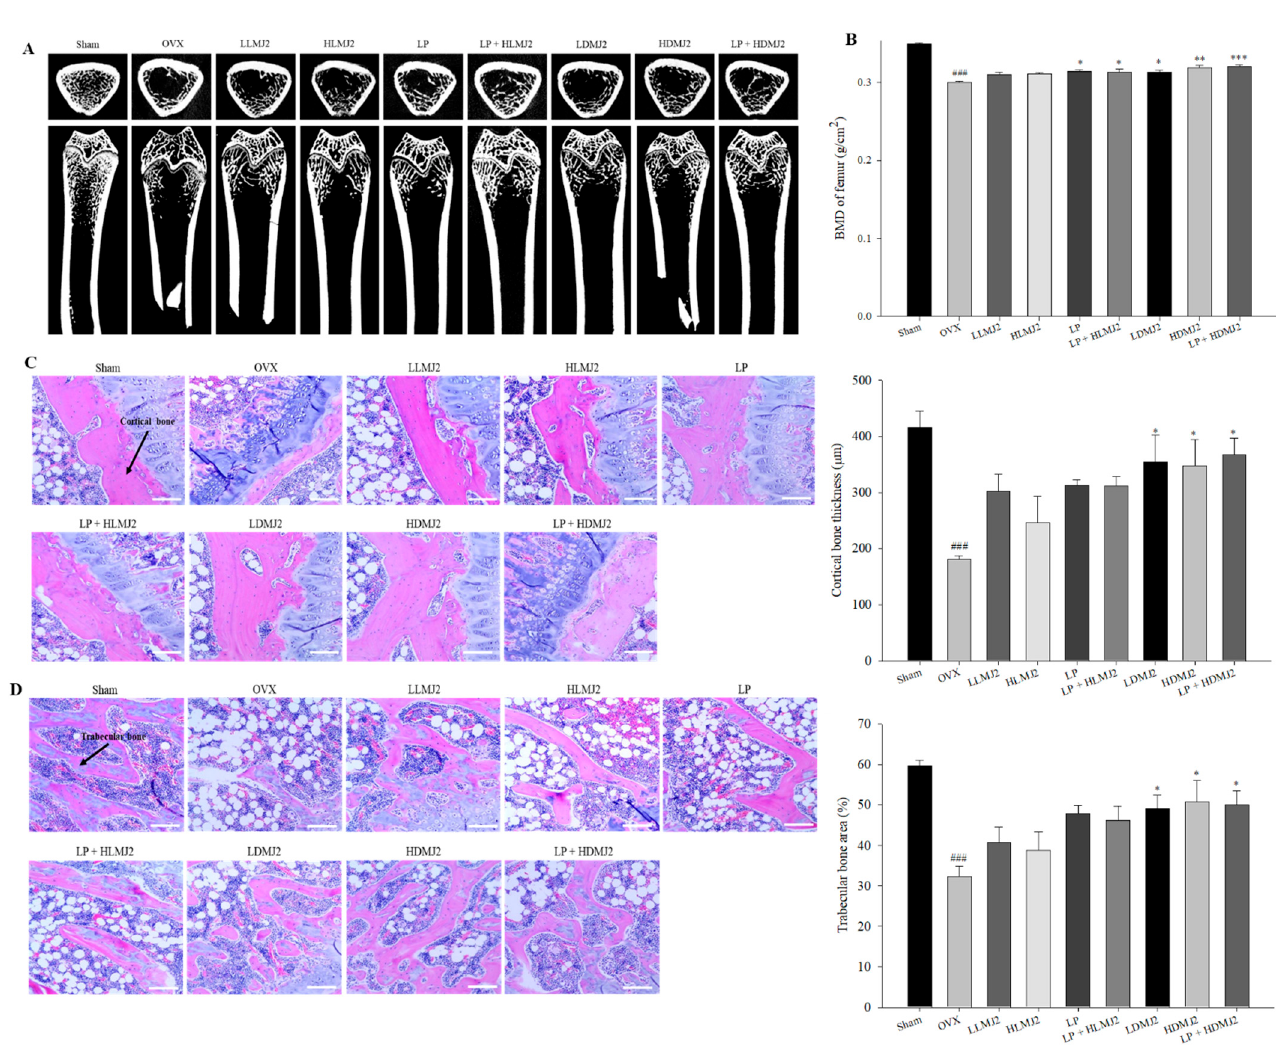
Figure 7. Effect of MJ2 and L. plantarum on osteoporotic bone mass and bone microarchitecture. 3D images of the femur of the hind limb were obtained by micro-CT ( A ). Bone mineral density (BMD) measured by dual-energy X-ray absorptiometry scanning was quantified ( B ). Bone microarchitecture (cortical bone ( C ) and trabeculae bone ( D )) was analyzed by H&E staining and quantified (×100, scale bar = 100 μ m). The values indicate the mean ± SEM. ### p < 0.001 compared with the sham group; * p < 0.05, ** p < 0.01, and *** p < 0.001 compared with the OVX group.